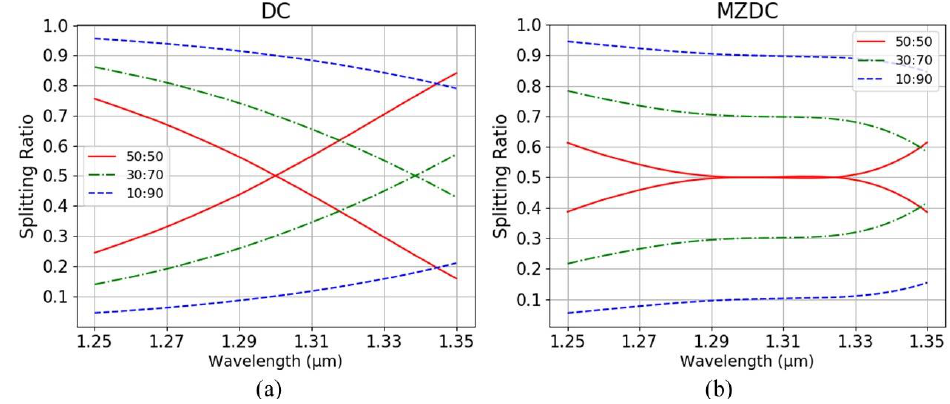
Figure 6. Splitting ratios of ( a ) DC and ( b ) MZDC.